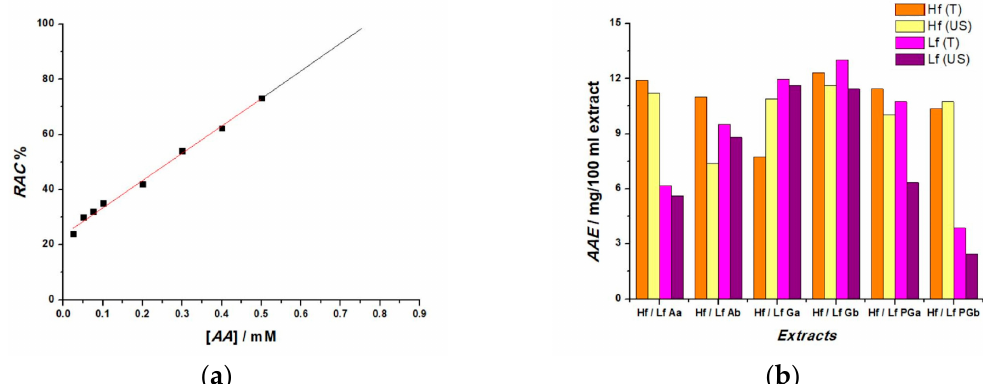
Figure 8. ( a ) Calibration plot for increasing AA concentrations and 0.5 mM H 2 O 2 obtained from fixed potential amperometry at 0.55 V vs. Ag/AgCl; ( b ) Histogram RAC expressed in terms of AAE.